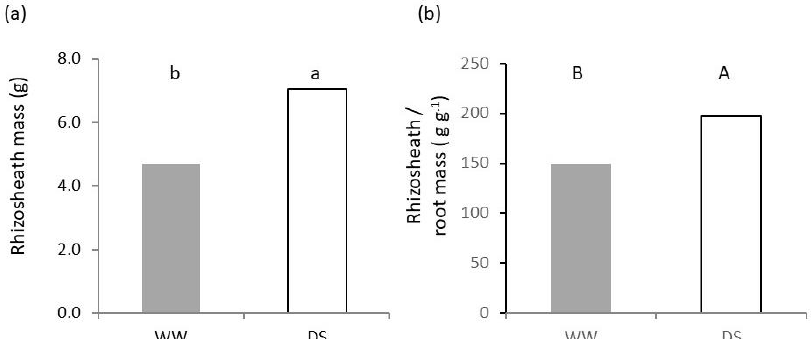
Figure 5. Effect of soil water availability on rhizosheath: ( a ) Rhizosheath dry mass; ( b ) rhizosheath/root dry mass. Different letters on each bar designate significantly different values at the Tukey’s post hoc mean separation test for p < 0.05 (lowercase letters) or p < 0.01 (uppercase letters).